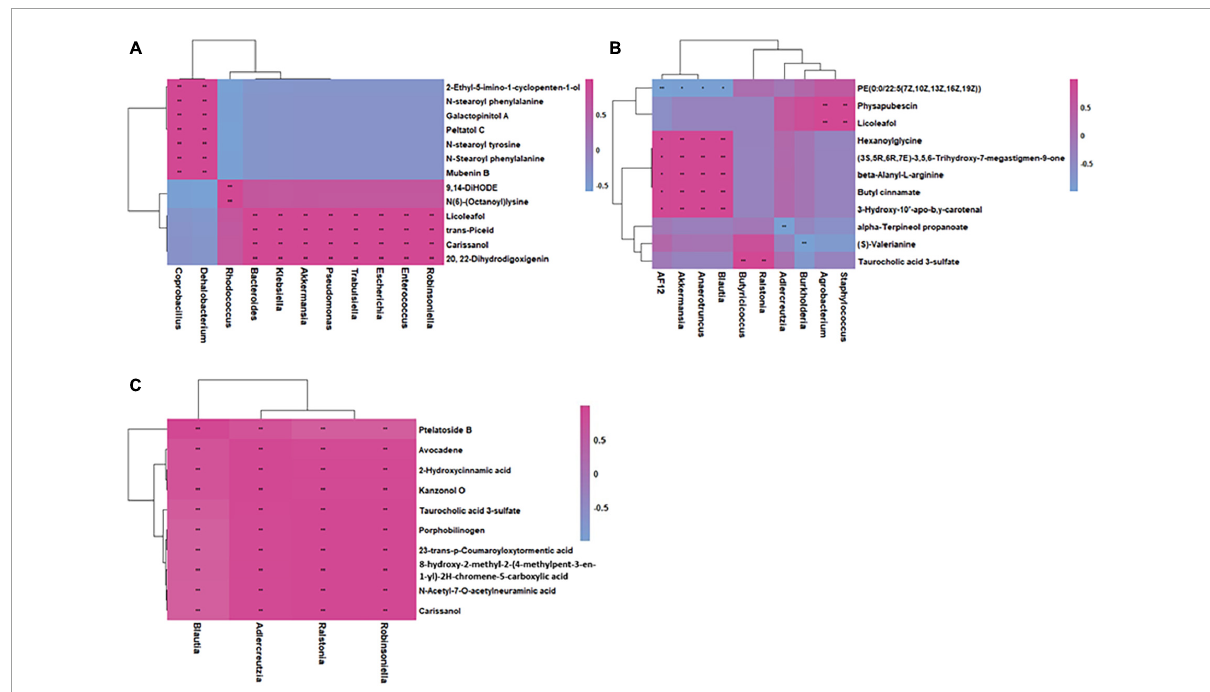
FIGURE7 Integrated correlation-based network analysis (Pearson’s correlation) of microbes and metabolites in health (A) , inflammation (B) , and CRC (C)